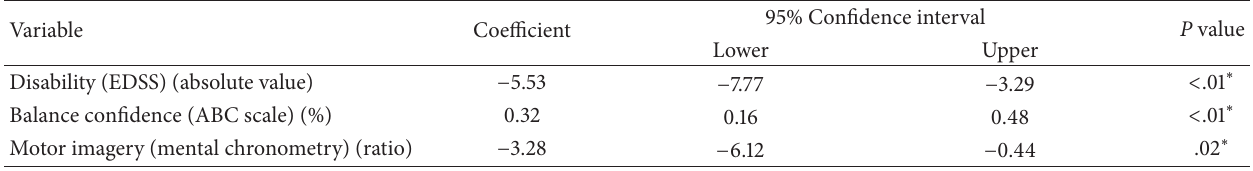
Table 3: Correlated factors with lower walking speed in persons with multiple sclerosis ( 𝑛 = 120 ).